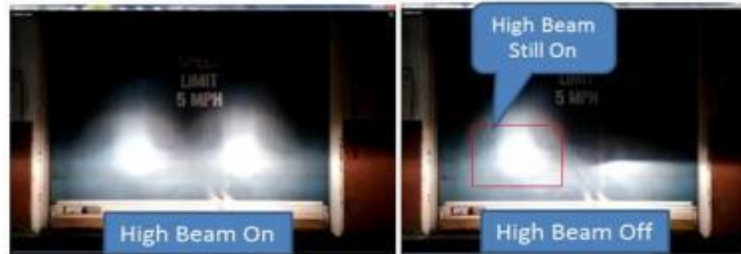
Figure 2. Fault phenomenon of a headlight system.